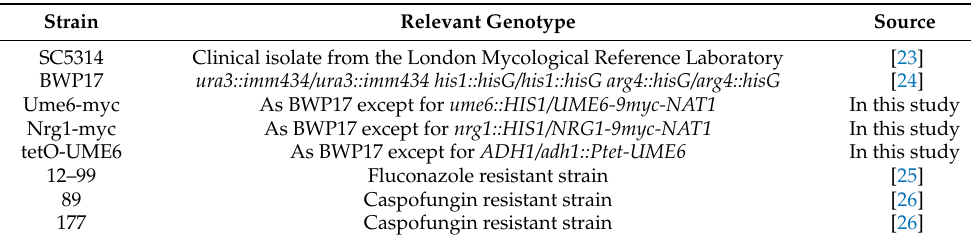
Table 1. Candida albicans strains used in this